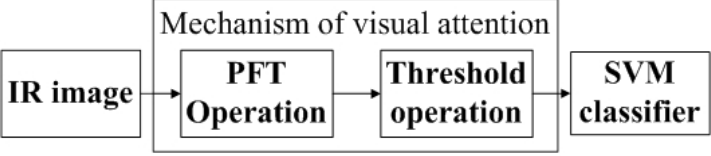
Figure 1. The proposed framework inspired by human visual system